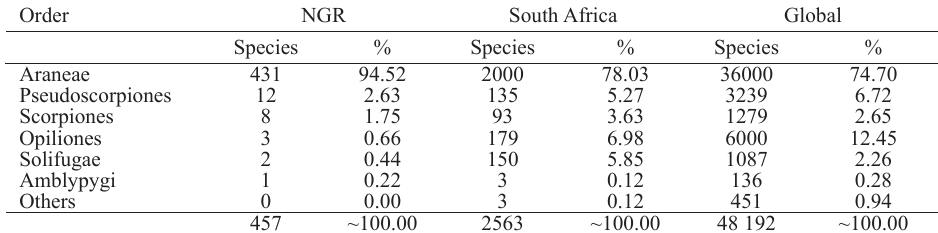
Table 2 Proportional diversity of the non-acarine arachnid orders in Ndumo Game Reserve relative to total South African (Dippenaar-Schoeman & Haddad, unpubl.) and global (Harvey 2002) diversity of each order